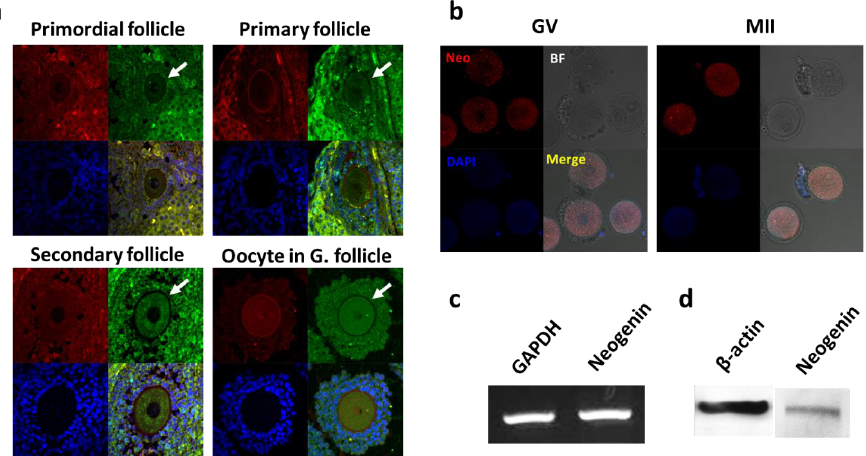
Figure 1. Expression profiling of neogenin in the ovary. ( a ) Confocal microscopic images of immunofluorescence staining with an anti-neogenin antibody in primordial follicle, primary follicle, secondary follicle, and oocyte in graafian follicle (oocyte in G. follicle). Neogenin, p63, and DAPI staining is shown in green, red, and blue, respectively. The arrow indicates a follicle positively stained for neogenin. ( b ) Confocal microscopic images of mouse oocytes. Neogenin and DAPI staining is shown in red and blue, respectively. GV, germinal vesicle; MII, metaphase II; BF, bright field. ( c ) RT-PCR analysis of neogenin mRNA in mouse oocytes. GAPDH was used as an internal control. ( d ) Western blot analysis of neogenin protein in mouse ovaries. β -actin was used as an internal control. Neo: Neogenin. Scale bar = 100 µ m. All data are representative of three replicates.